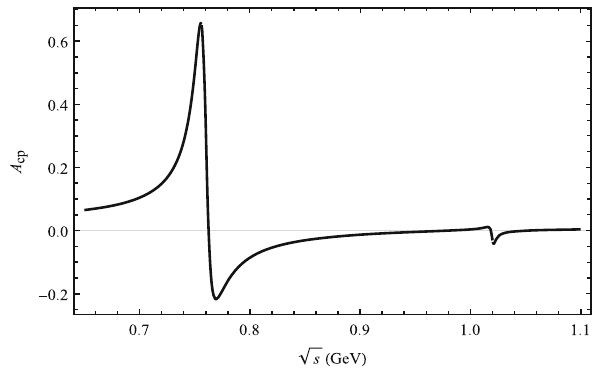
√ s corresponding to central